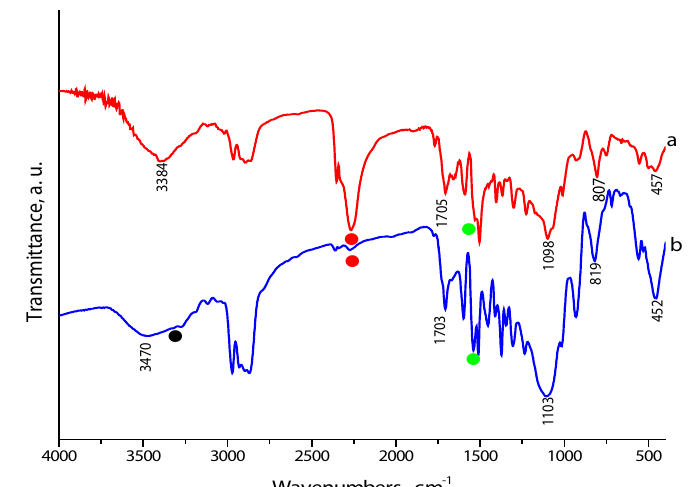
Figure 4. FTIR spectra for PU/10BG (a) and PU/20BG (b), before in vitro test.